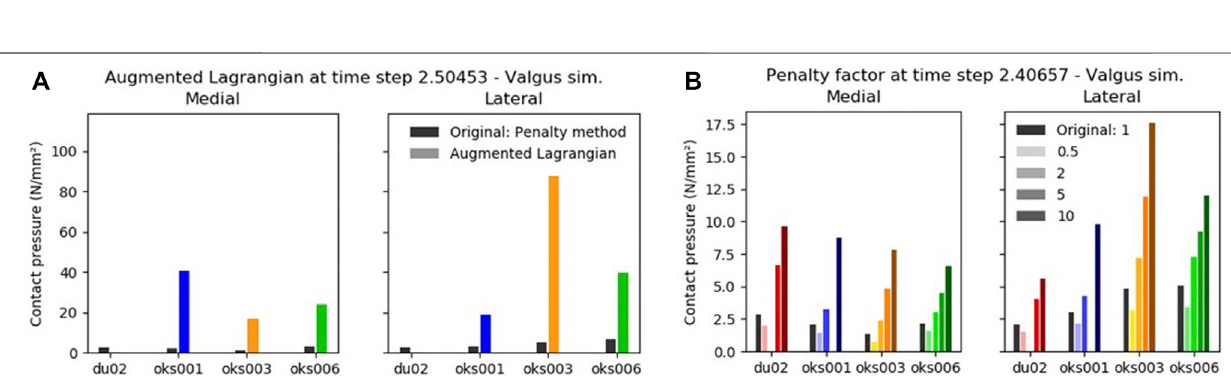
FIGURE 8 | Ligament attachment condition sensitivity analysis simulation results rated on in fl uence on convergence, valgus kinematics, peak contact pressure, and location of peak contact pressure (0 (No in fl uence) to 3 (Large in fl uence)).